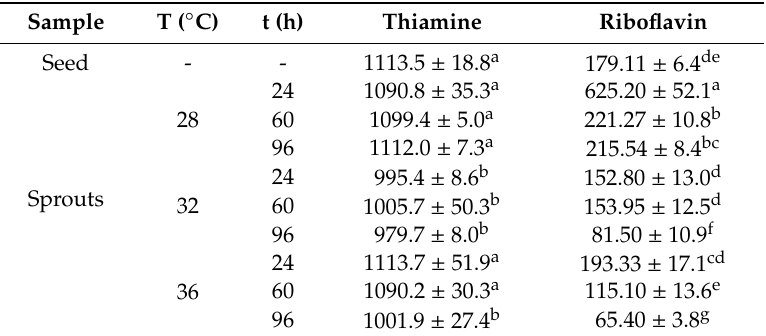
Table 2. Content of thiamine and riboflavin ( µ g / 100 g d.m.) in moringa seed and their sprouts obtained at di ff erent germination